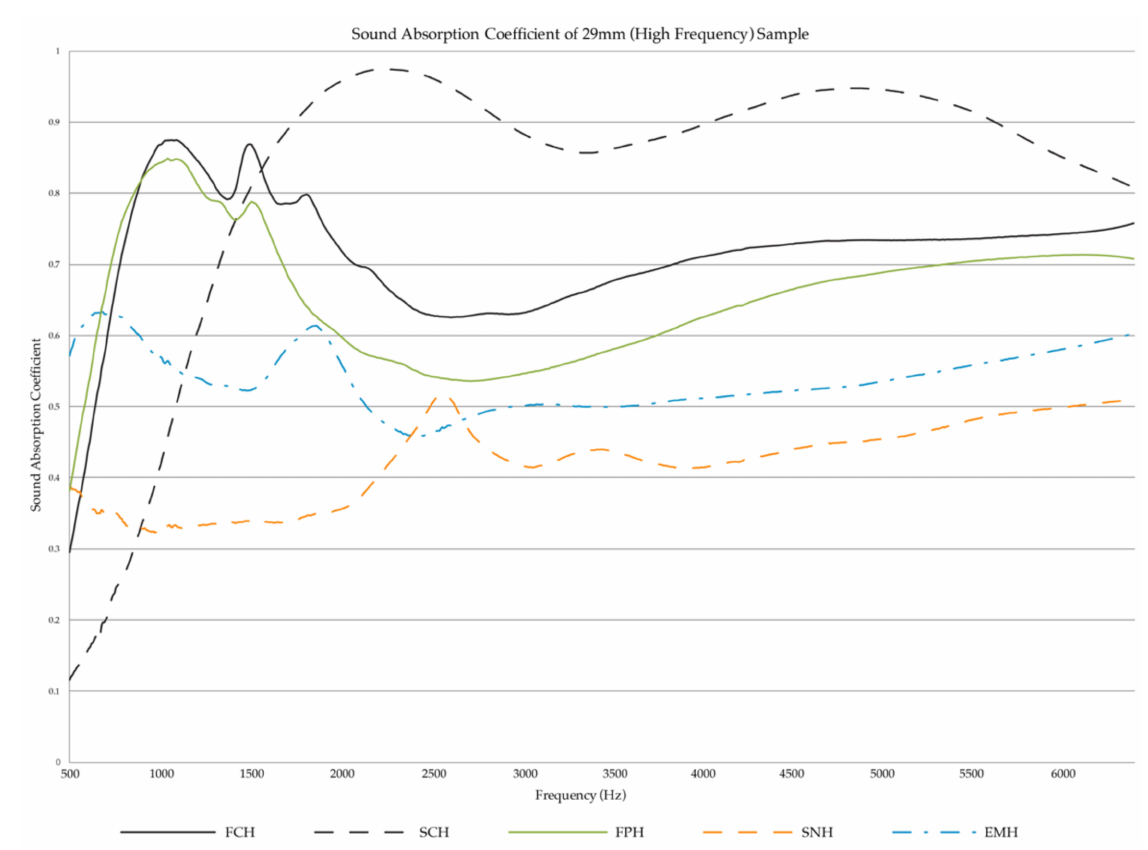
Figure 8. Sound Absorption Coefficients of high frequency samples (29 mm).